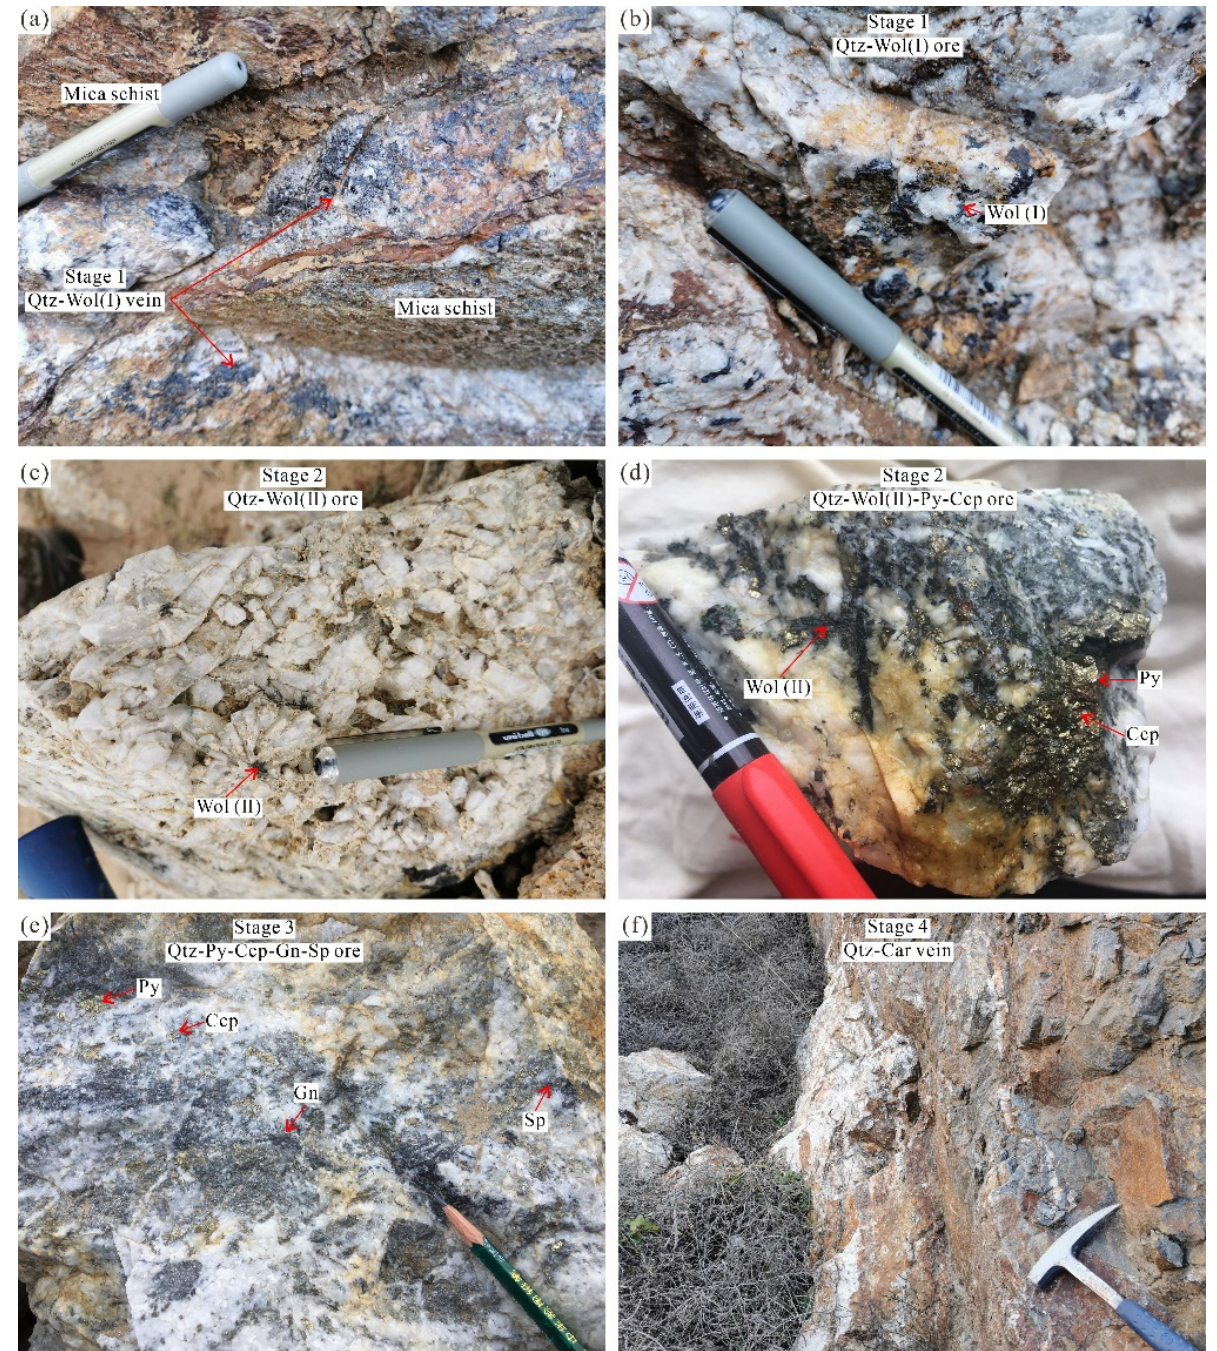
Figure 4. Representative photographs of the mineralization at the Baishitouwa deposit. ( a ) Quartz– Wolframite (I) veins of stage 1 crosscut the country rocks (mica schist); ( b ) Quartz–Wolframite (I) ore of stage 1; ( c ) Quartz–Wolframite (II) ore of stage 2; ( d ) Quartz–Wolframite (II)–pyrite–chalcopyrite ore of stage 2; ( e ) Quartz–pyrite–chalcopyrite–sphalerite ore of stage 3; ( f ) Quartz–carbonate veins of stage 4. Abbreviations: Qtz, quartz; Wol (I), early generation of wolframite; Wol (II), late generation of wolframite; Py, pyrite; Ccp, chalcopyrite; Gn, galena; Sp, sphalerite; Car,